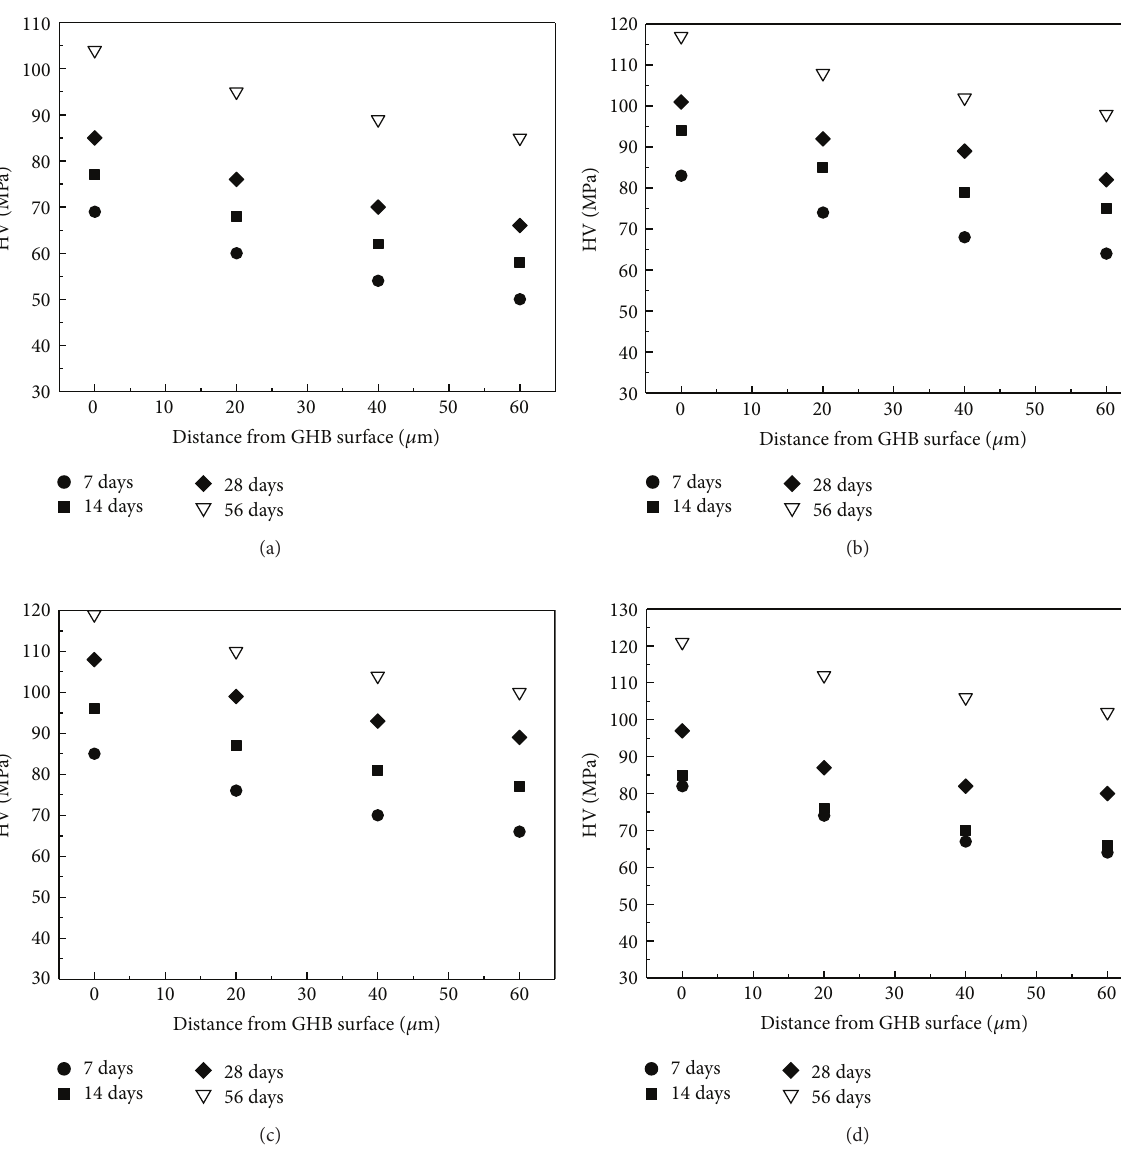
Figure 6: The influence of age of curing on the interfacial HV of lightweight aggregate concrete: (a) NS content 0%, (b) NS content 0.25%, (c) NS content 0.5%, and (d) NS content 0.75%.